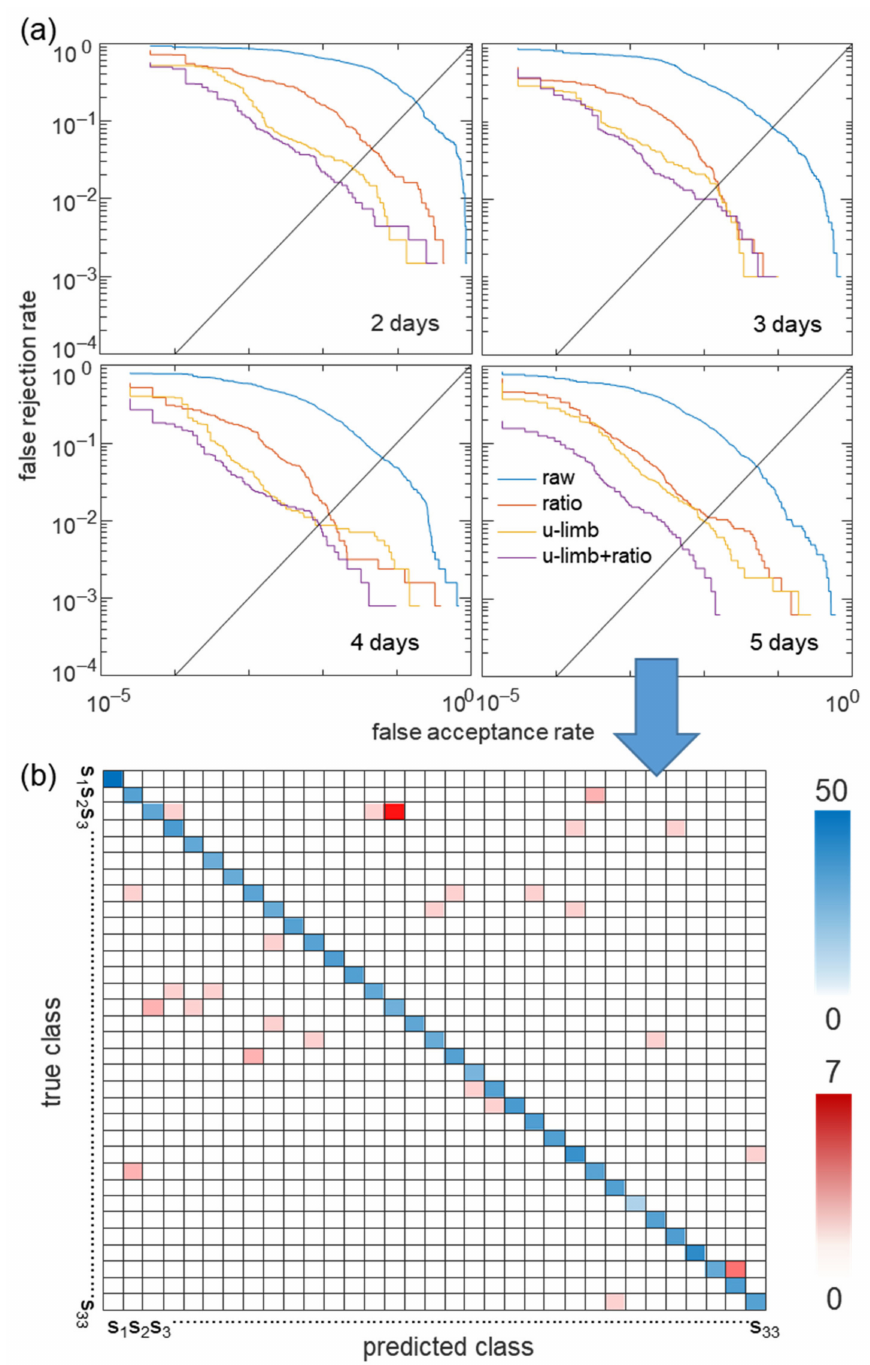
Figure 7. Individual identification performance with increasing date of measurement and accord- ing to four different types of features used ((i) the raw finger impedance, (ii) ratiometric features, (iii) upper limb impedance only and (iv) ratiometric features together with upper limb